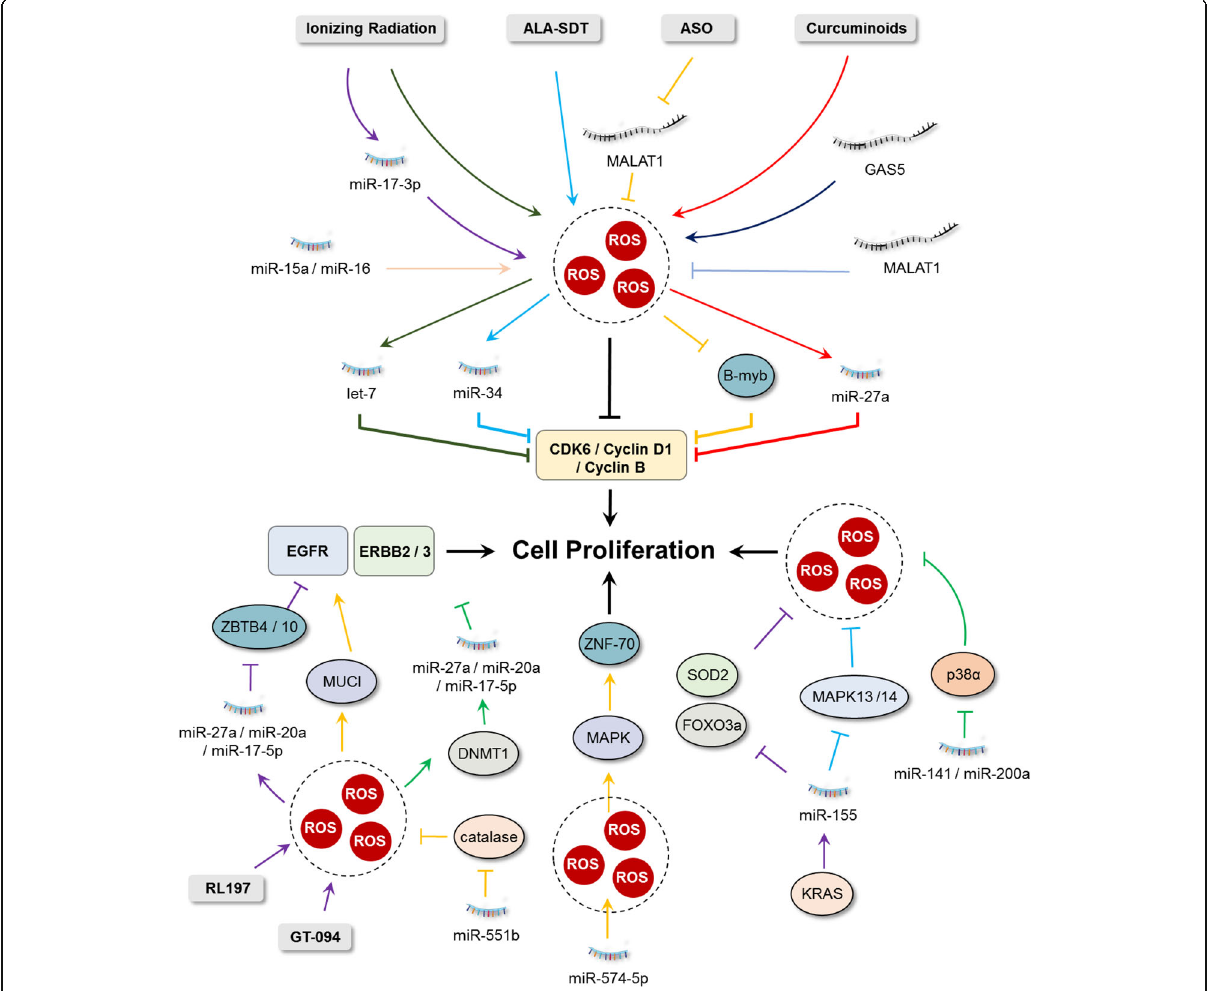
Fig. 1 Interplay between ROS and ncRNAs in regulating cancer cell proliferation. Cyclins and cyclin-dependent kinases (CDKs), especially CDK4/6 and Cyclin B/D1, are directly regulated by a variety of ncRNAs, some of which are closely related to cellular ROS. The important roles of interactions between RTKs (including EGFR and MAPK), ncRNAs and ROS in cancer cell proliferation are